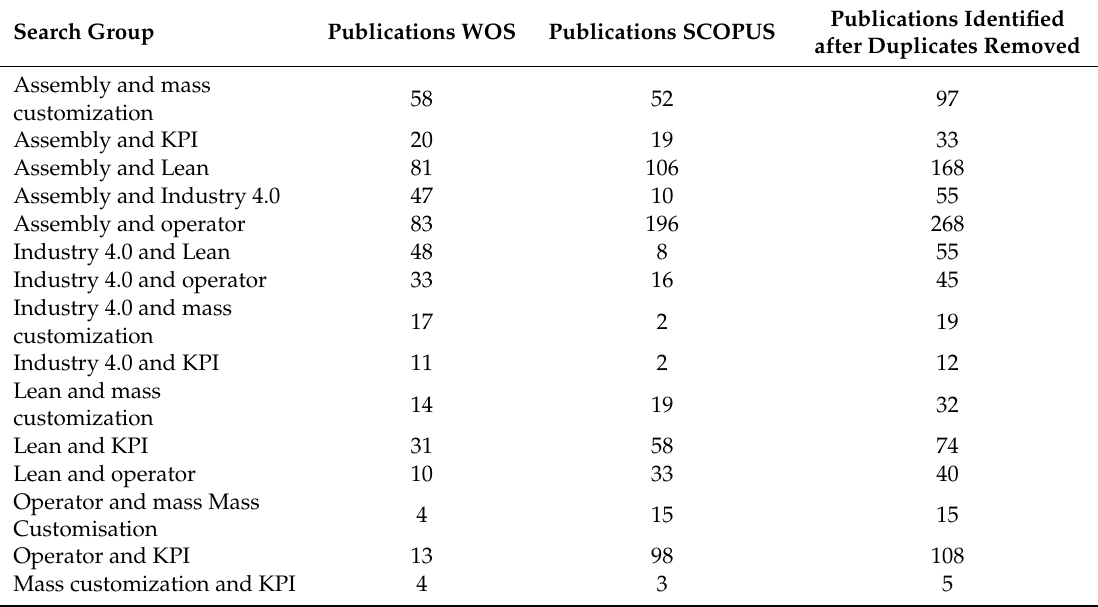
Table 1. Search groups created by the intersection of each pair of key concepts and number of publications found.